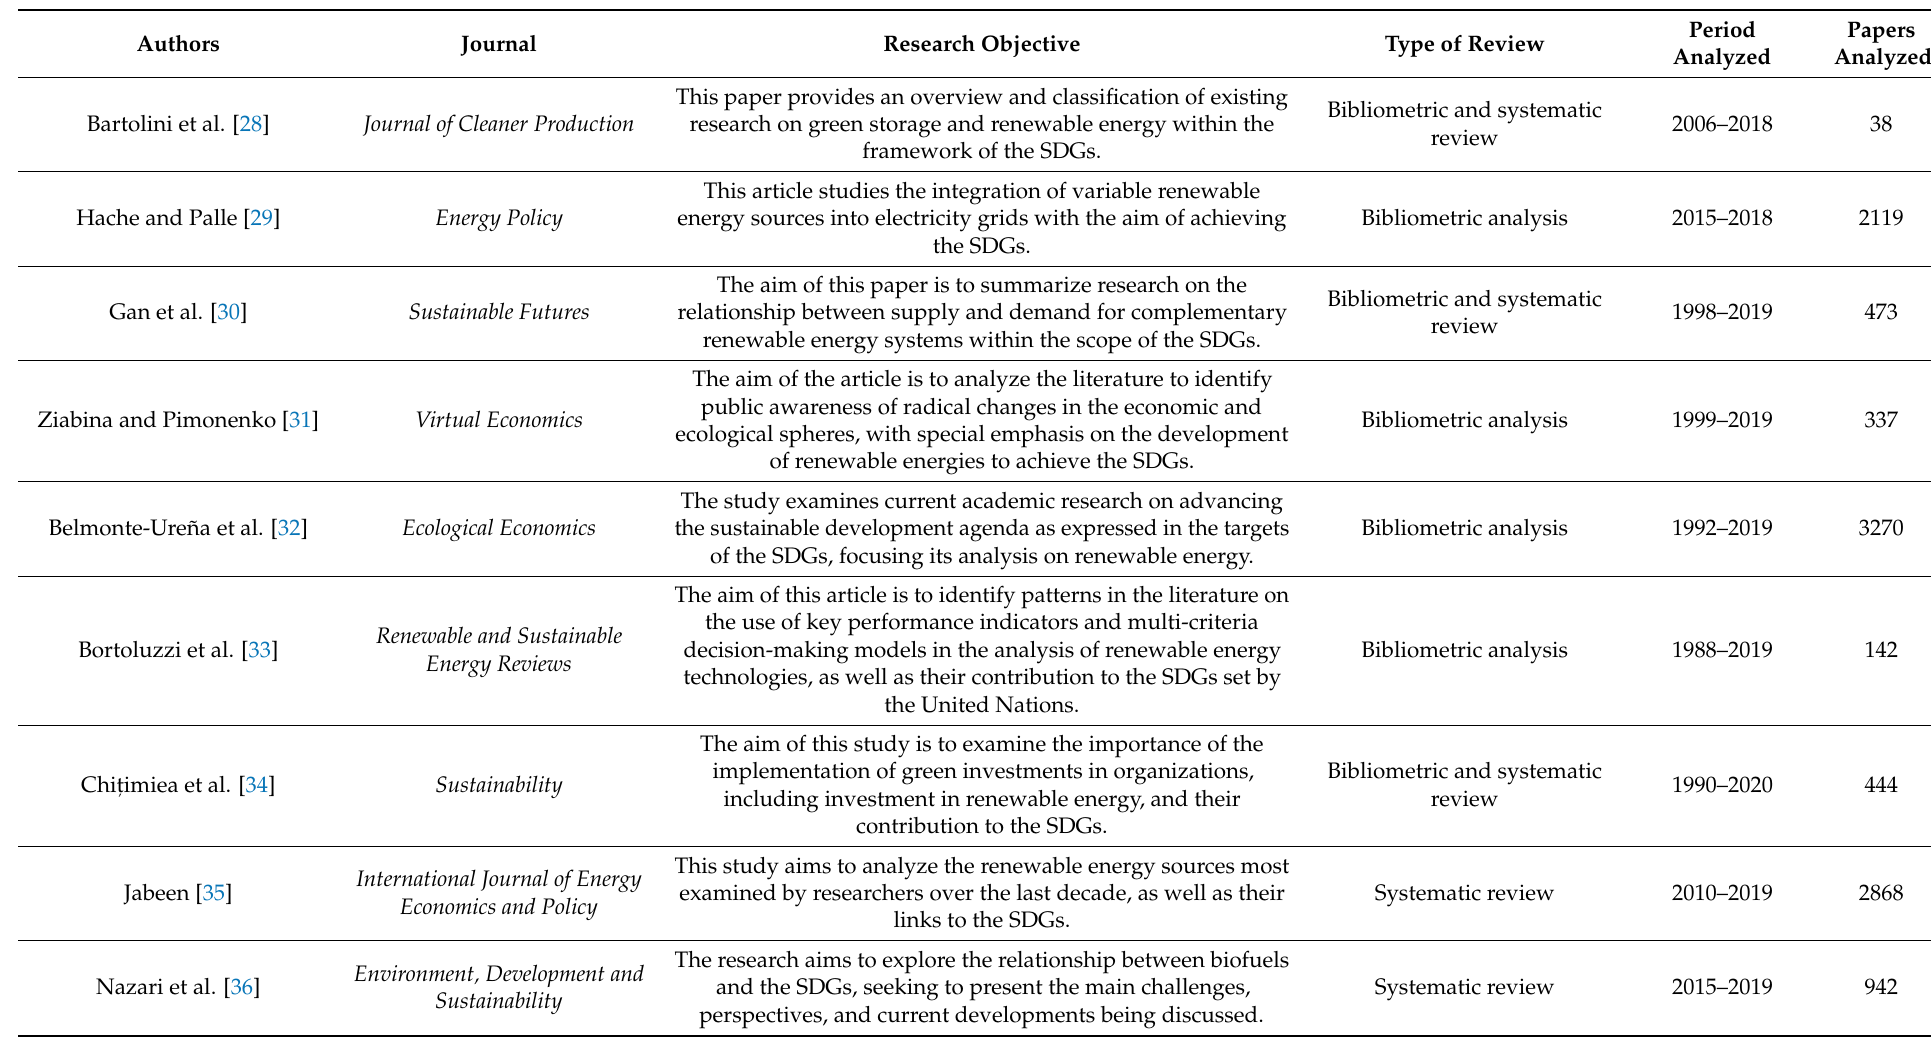
Table 1. Reviews indexed in the Web of Science core collection on linking the SDGs and renewable